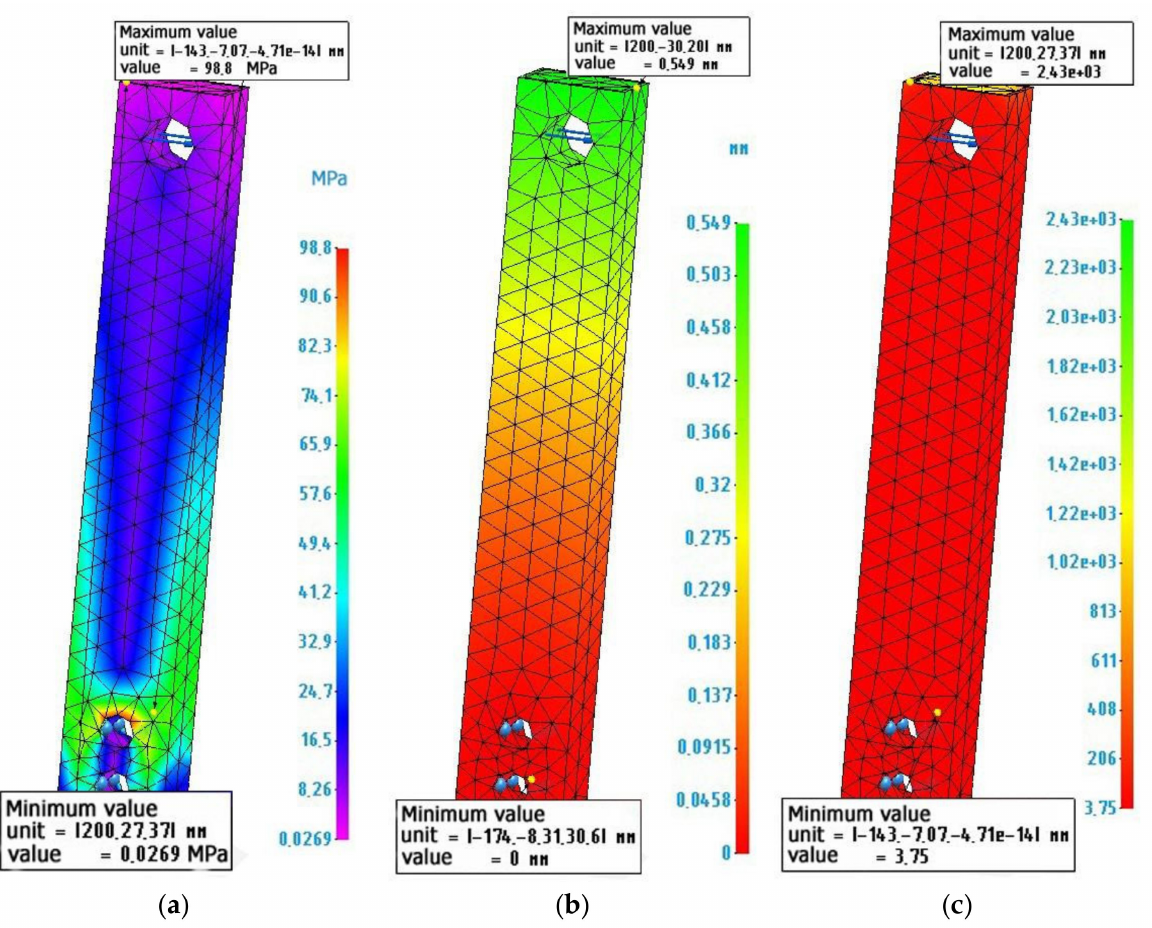
Figure 10. Finite element calculation of a metal-metal-polymer composite sample: ( a ) Stress diagram according to von Mises, the maximum value is 98.8 MPa; ( b ) Strain diagram, maximum value 0.549 mm: ( c ) Safety factor diagram, minimum value